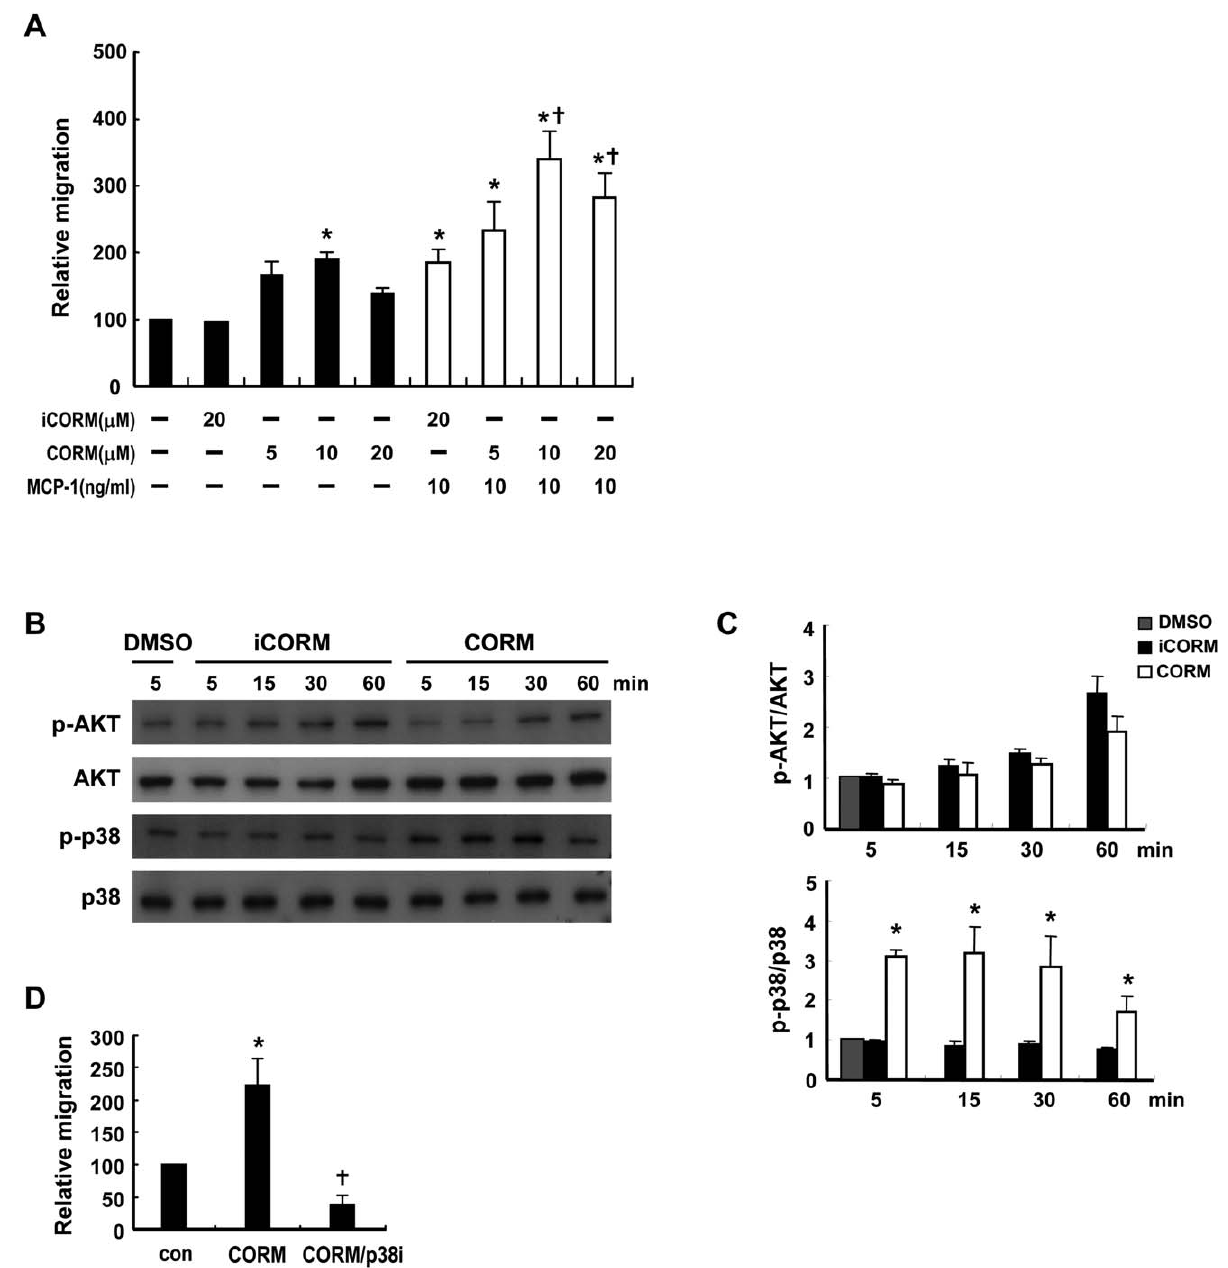
Figure 8. CO promotes macrophage migration by modulating p38 signaling. A, Peritoneal macrophages from WT mice were tested in a transwell migration assay without or with MCP-1 (10 ng/ml). Macrophages in the upper chamber were concurrently treated without or with the indicated concentrations of CORM-2 or iCORM-2. The data are the mean 6 SEM for three independent experiments. * P , 0.05 vs the untreated control.; { P , 0.05 vs the MCP-1-treated cells. B, WT macrophages were treated with 10 m M iCORM-2 or CORM-2 for the indicated time, then phosphorylation of p38 or AKT was examined by Western blot analysis. C, The levels of phospho-p38 and phospho-AKT were quantified by densitometry. The data were presented as the normalized intensity relative to that of DMSO-treated group, which was set to 1. The results shown are the mean 6 SEM for three independent experiments. * P , 0.05 vs iCORM-2-trerated cells. D, Transwell migration assay performed using macrophages treated without or with 10 m M CORM-2 in the absence or presence of SB203580 (20 m M). The data shown are the mean 6 SEM for four independent experiments. * P , 0.05 vs the untreated control. { P , 0.05 vs CORM-2 treatment. The relative migration is the migration of the treated group expressed as a percentage of that of the control group.